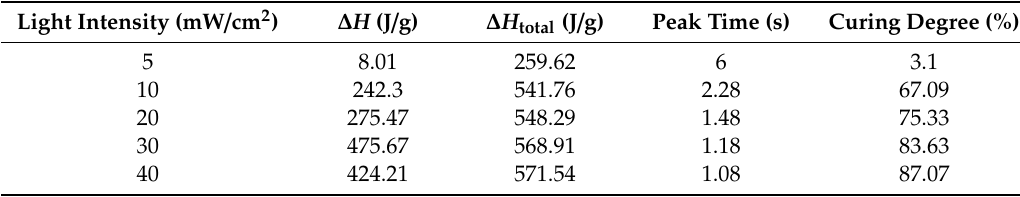
Table 1. properties analysis results for different light intensities.